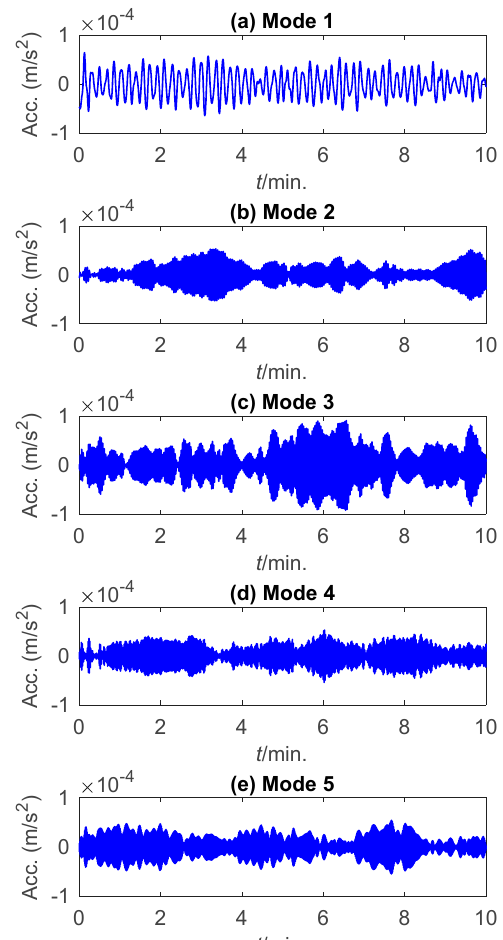
Figure 8. ( a ) The time history of the analyzed acceleration data from Canton Tower; ( b ) the detected boundaries in the Fourier spectrum.